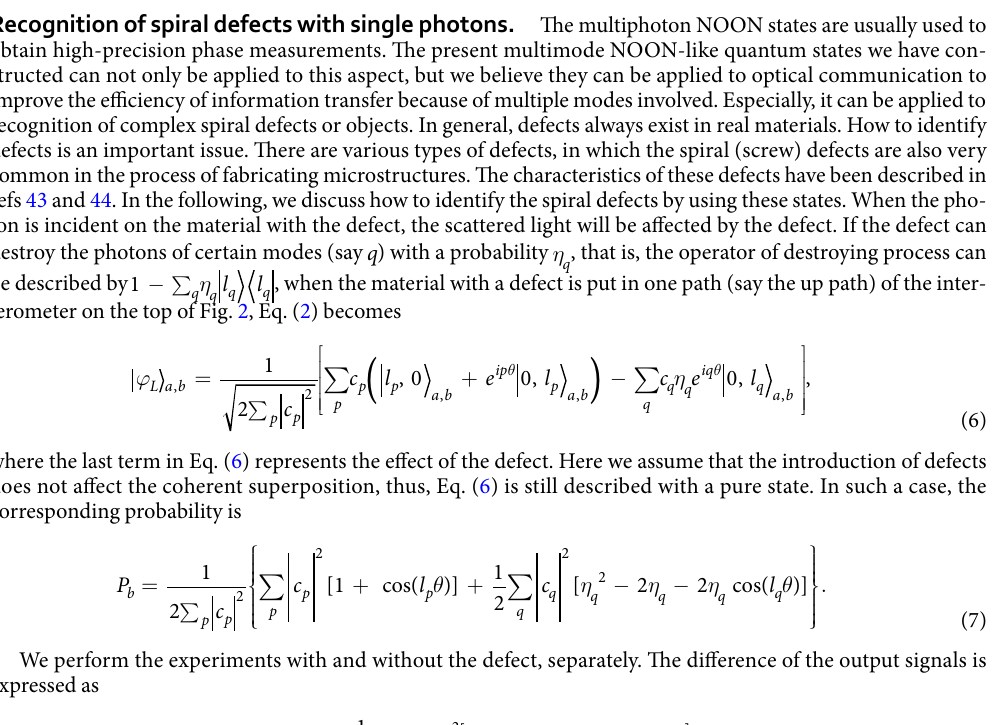
circle dots represent the experimental results and the solid lines are corresponding normalized theoretical results. The l -fold improvement for the angular measurement precision is observed clearly.